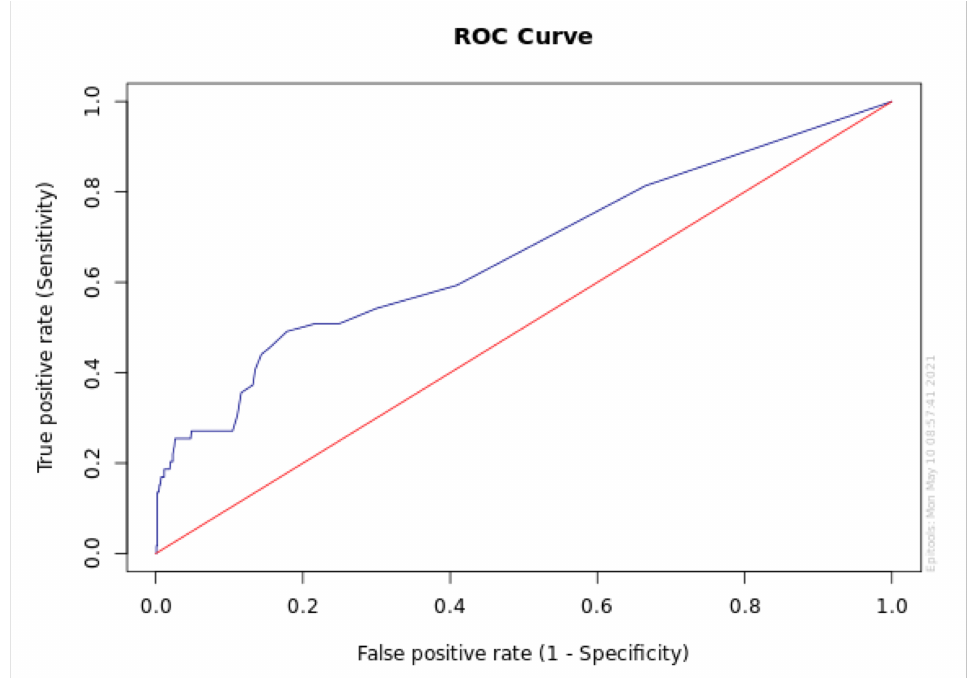
Figure 2. ROC curve with sensitivity as a function of 100%—specificity. CRP level vs.